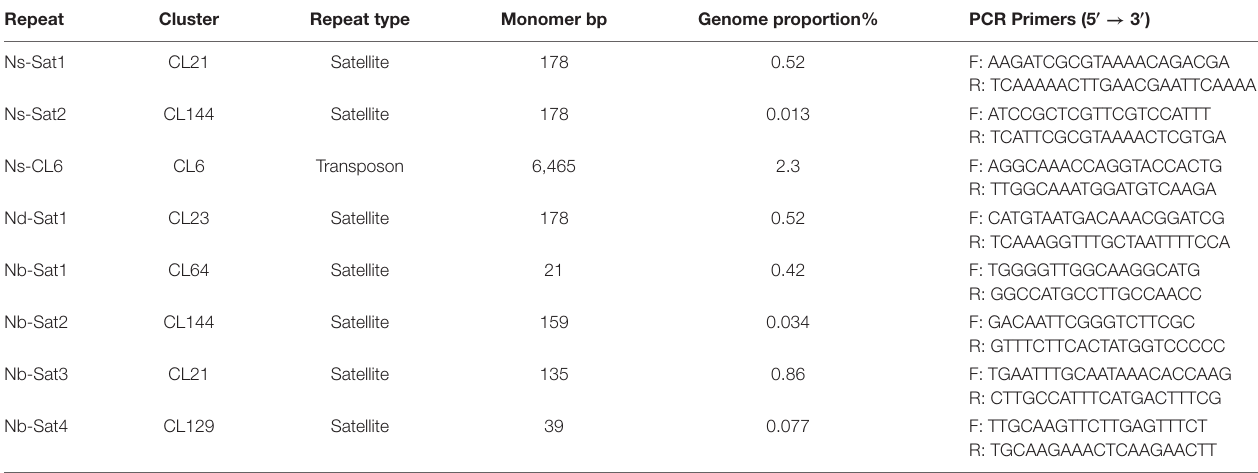
TABLE 3 | Repeats used as probes in FISH experiments on N. sativa , N. damascena and N. bucharica